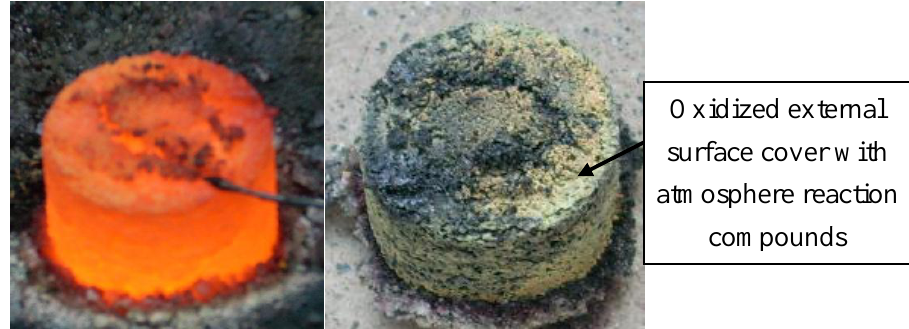
Figure 2. Reaction process and obtained SHS product without reactor.